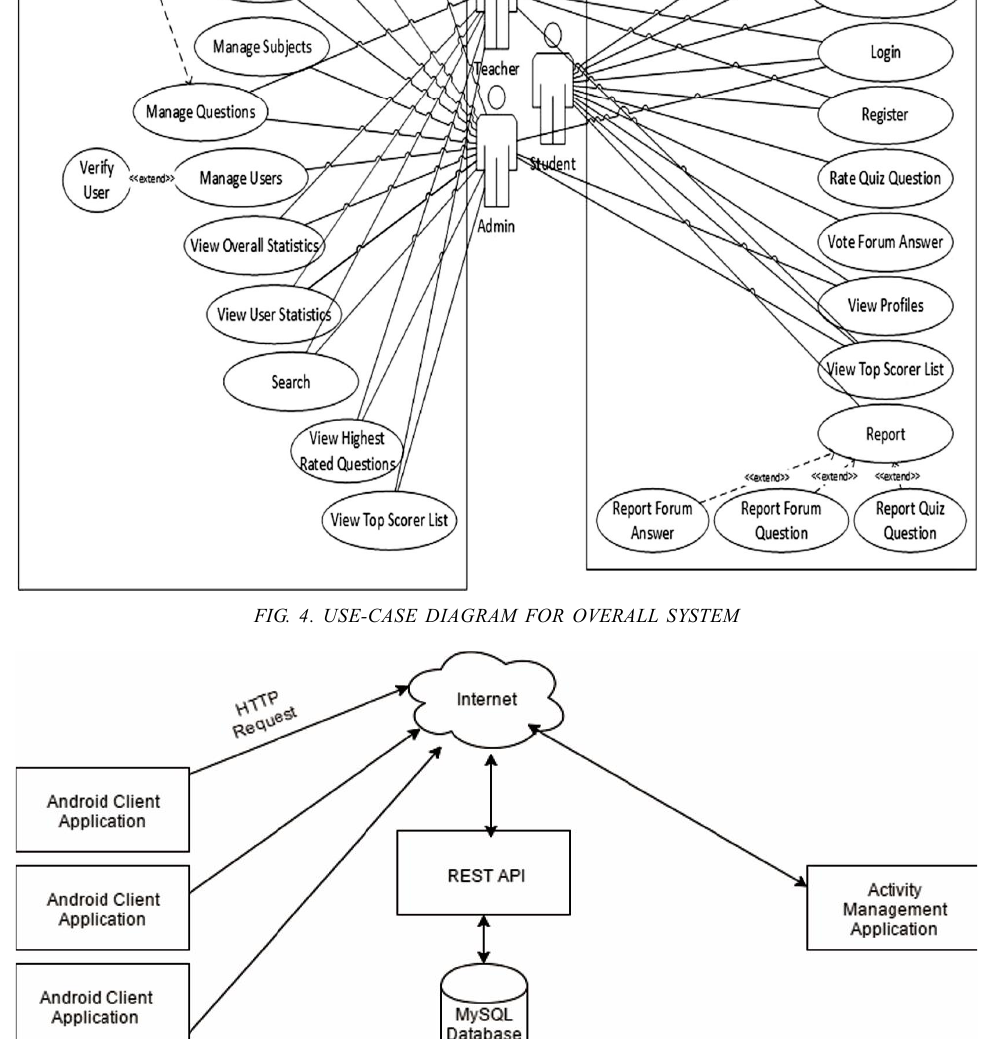
FIG. 5. SYSTEM ARCHITECTURE